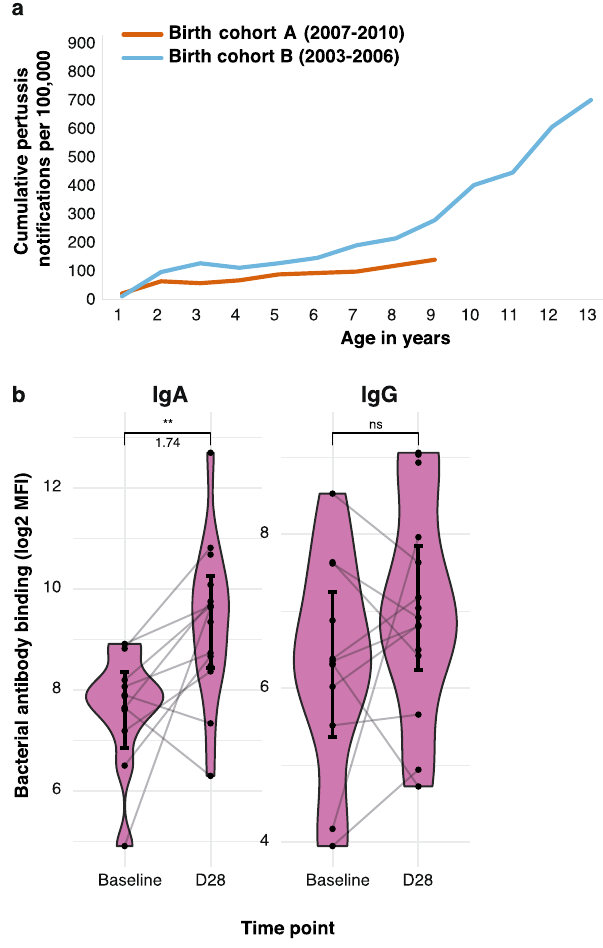
Fig. 3 | Cumulative B. pertussis disease incidence in different aP-primed birth cohortsovertimeandimpactofasymptomaticinfectiononmucosalantibody responses. a Cumulative pertussis disease incidence for aP-primed birth cohorts including children born between 2007 and 2010 (red line) and between 2003 and 2006 (blue line), representing cohorts A and B, respectively. Pertussis disease incidencewasobtainedforpostcode-matchedregionswherethevaccinationstudy was conducted, covering the period from birth until the start of the BERT study. The solid lines re fl ect the cumulative pertussis disease incidence as the pertussis noti fi cations/100,000inhabitants. b MLFwasobtainedfromadultvolunteersprior to (day − 7, baseline) and 28 days after intranasal inoculation with B. pertussis . Bp_mut , de fi cient for FHA, PRN, and PT, was incubated with heat-inactivated MLF and antibody binding was subsequently measured by fl ow cytometry. Log2- transformed mean fl uorescence intensity (MFI) of IgA and IgG binding to Bp_mut . Data are N =10. Sample means with 95% CI (solid black point and line) are plotted. Kruskal – Wallis followed by Wilcoxon signed-rank test was used to test signi fi cant differences over baseline in the controlled human infection study. ** p ≤ 0.01, p =0.0042 for